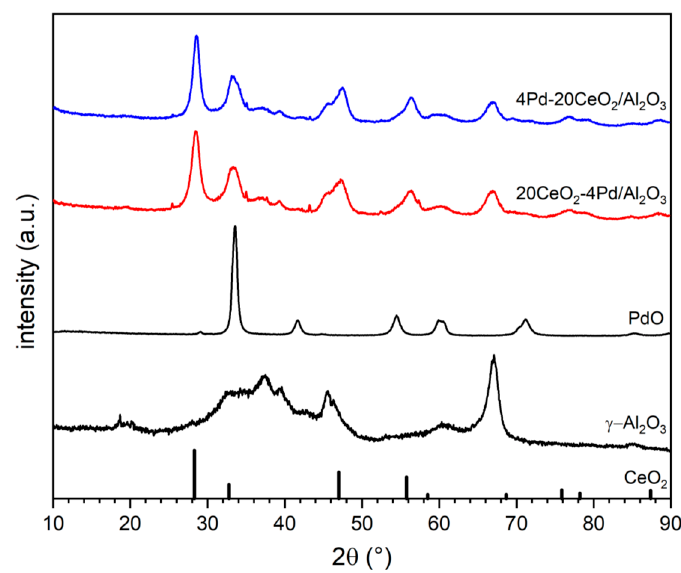
Figure 2. XRD of two catalysts, PdO and the supports.